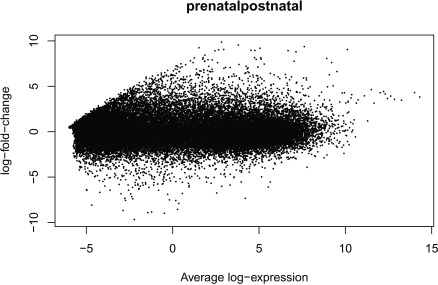
MA plot of the gene level data.Testing for prenatal and postnatal DE adjusting for sex and RIN.